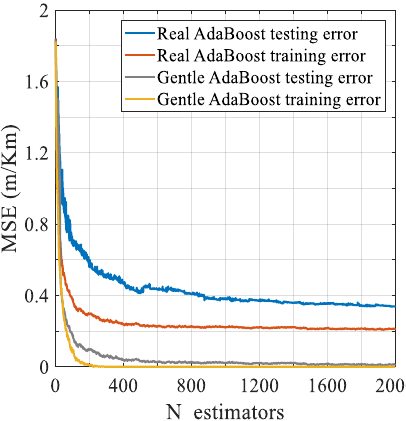
Figure 4. Real and Gentle error decay curve.